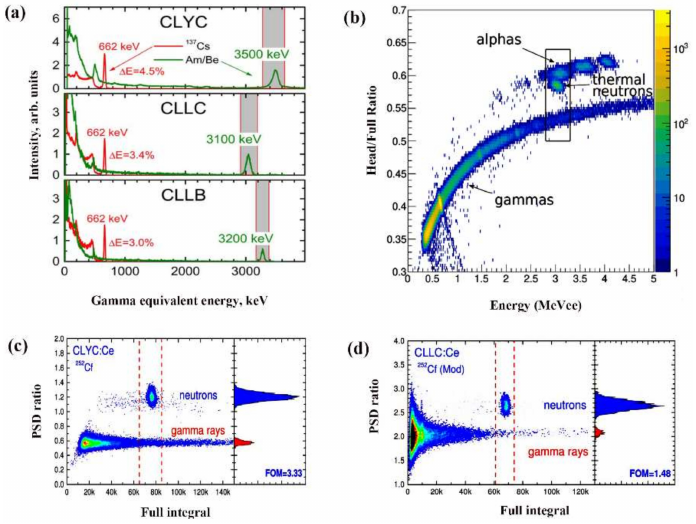
Figure 11. ( a ) A comparison of Cs and 241 Am/Be energy spectra measured for CLYC, CLLC, and CLLB samples. Reproduced with permission [45]. Copyright 2013, Elsevier B.V. ( b ) A PSD scatter plot of CLLB. Reproduced with permission [55]. Copyright 2017, Elsevier B.V. ( c , d ) A PSD scatter plot of CLYC and CLLC. Reproduced with permission [54]. Copyright 2012, IEEE-INST Electrical Electronics Engineers